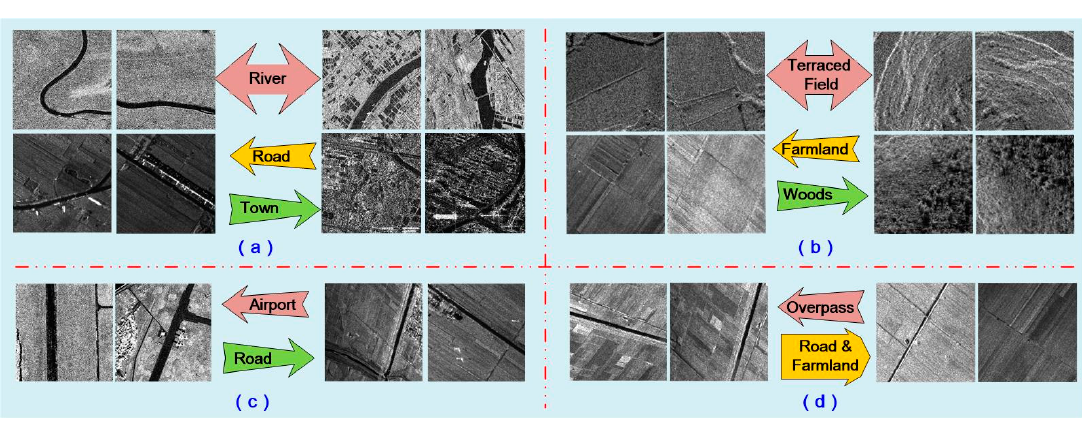
illustrated in Figure 10c. For the river scene, there were 5% and 1.7% misclassifications as road and